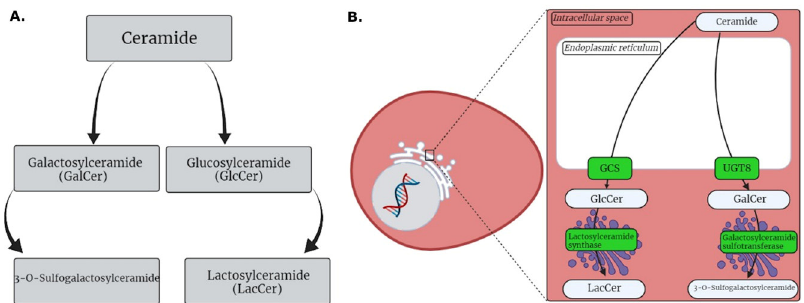
Figure 5. Graphical presentation of sphingolipid metabolism. ( A ) Ceramide glycosylation pathways adapted from MetaboAnalyst 5.0; ( B ) The proposed escape routes of tumor cells (lactosylceramide biosynthesis and sulfatide biosynthesis) adapted from KEGG MODULE Database.